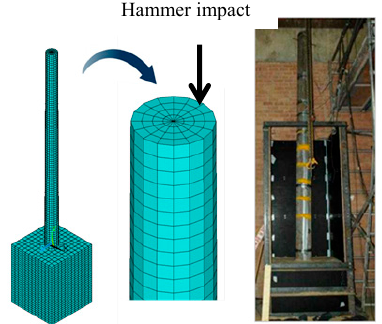
Figure 7. Experimental setup and the FE model.